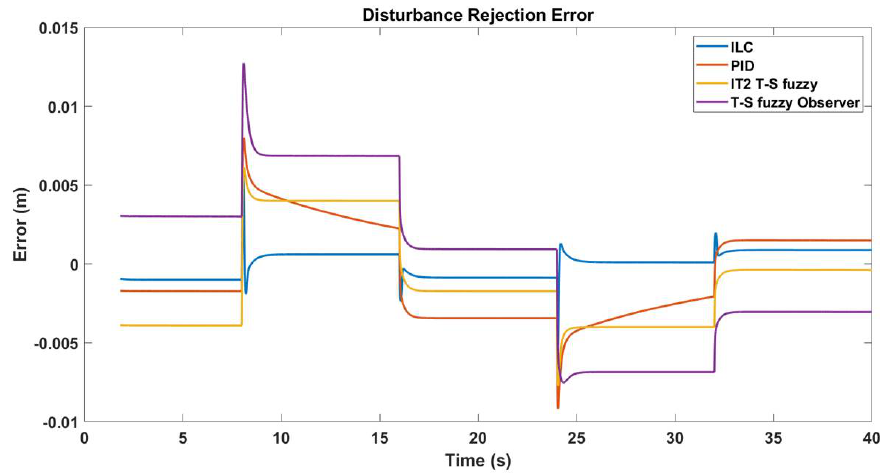
Figure 15. The comparison between the controllers’ performance in the disturbance rejection.